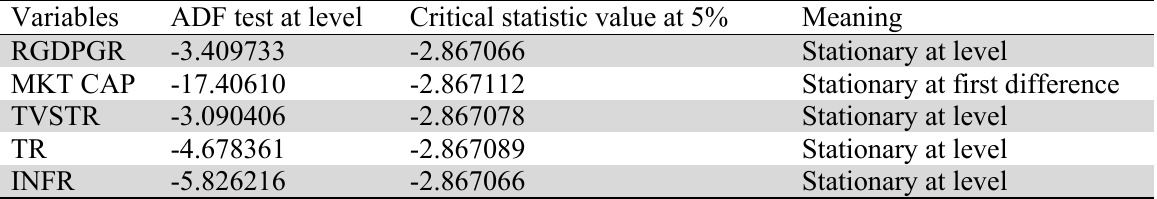
Summary of unit root